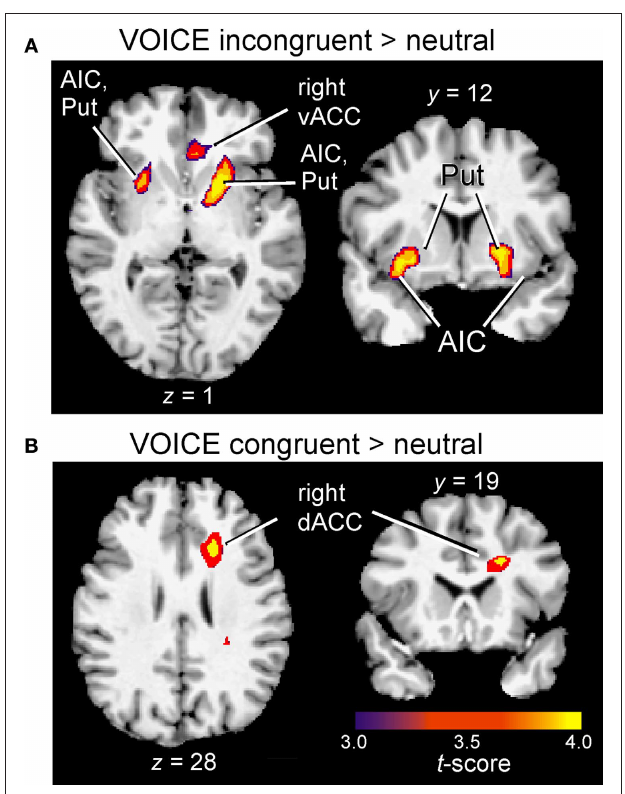
FIguRe 5 | Insular and subcortical activation associated with interference (A) and facilitation (B) in the VOICE task. Cluster-wise activation threshold = p < 0.01, corrected. AIC, anterior insular cortex; dACC, dorsal anterior cingulate; Put, putamen; vACC, ventral anterior